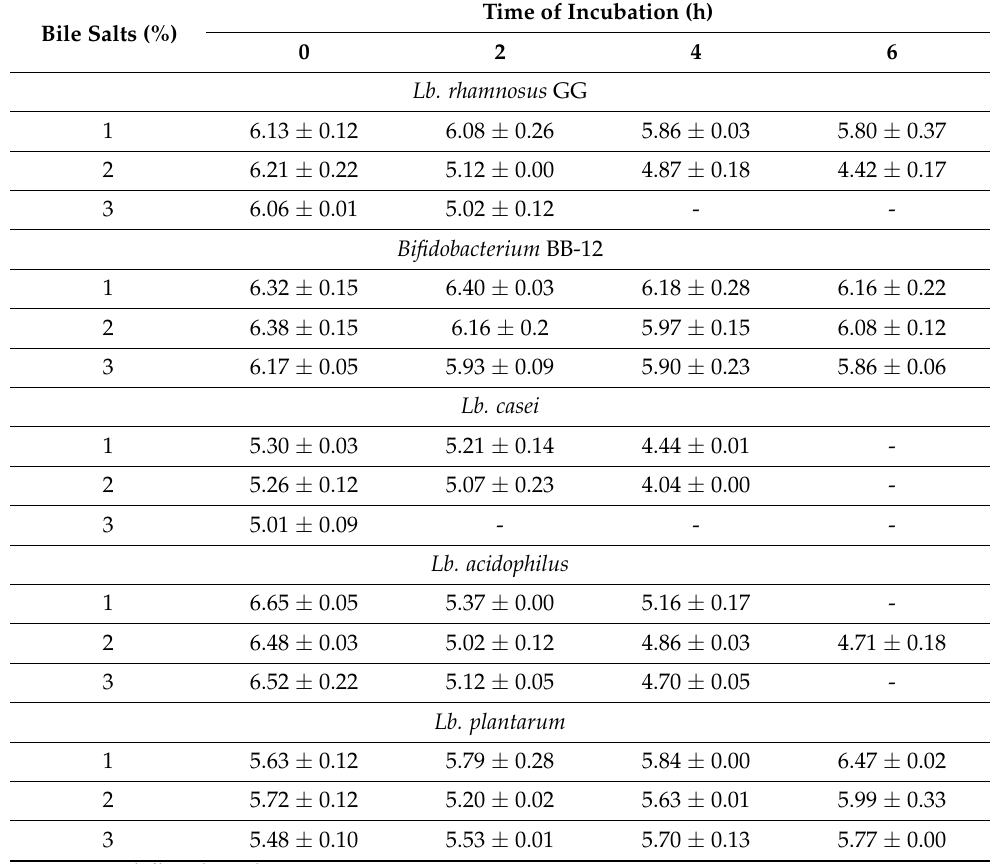
Table 4. Survival of commercial probiotic strains (log CFU mL − 1 ± SD) in the food matrix under simulated condition of the gastrointestinal